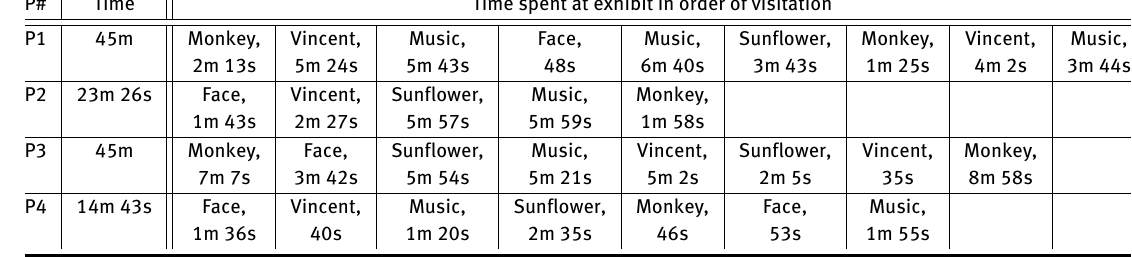
Table 3. Summary of second in-robot gallery visitation (S2)